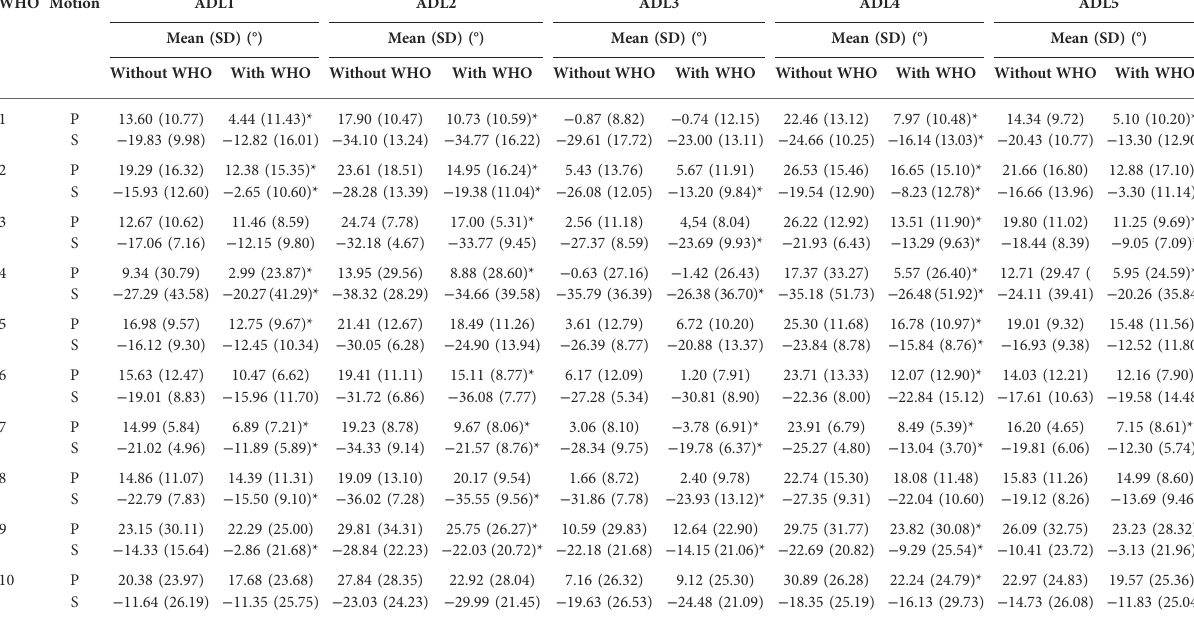
TABLE 8 Mean maximum pronation and supination with and without WHOs by ADLs.